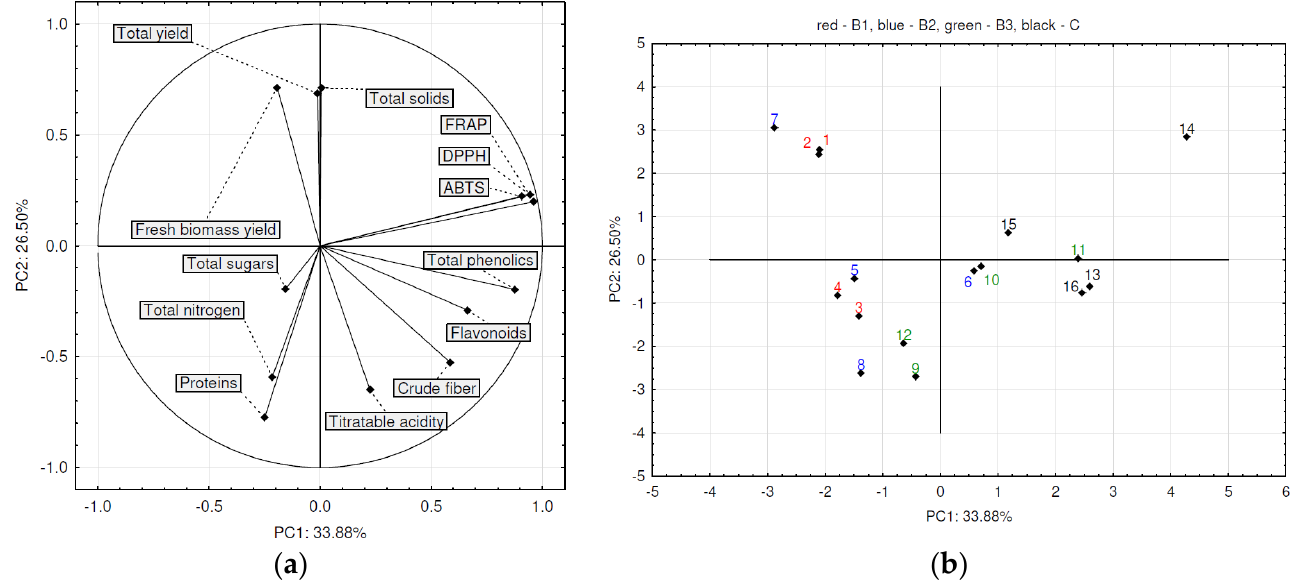
Figure 5. PC1-PC2 presentations as a result of PCA of onion samples deriving from 16 treatments of from sets (DS) onion: ( a ) loadings and ( b ) scores plot. Legend: 1, no 1 in appendix A; 2, no 3 in